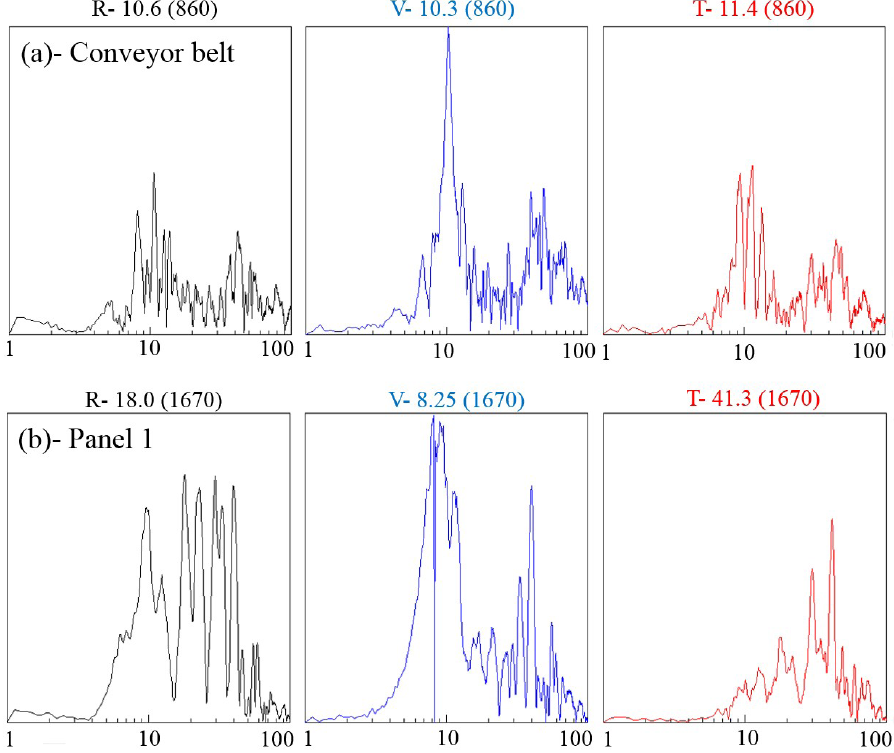
Figure 6: Fast Fourier Transform (FFT) analysis of the vibration signal at (a) “Conveyor belt” site and (b) “Panel 1 (Upper exploitation